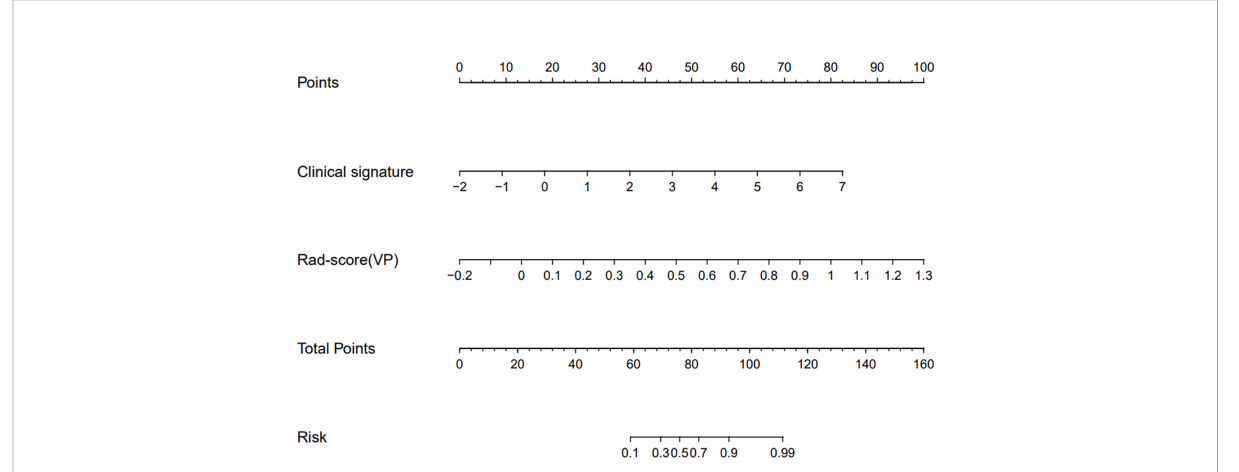
FIGURE 4 Nomogram based on the clinical signature and radiomic signature in venous phase to predict the pathological subtypes of NSCLC